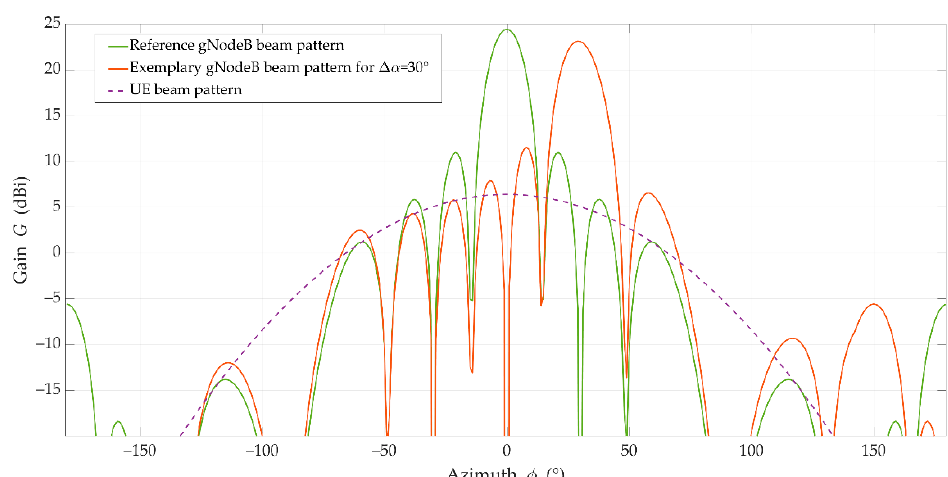
Figure 5. 3D pattern of reference beam [38].